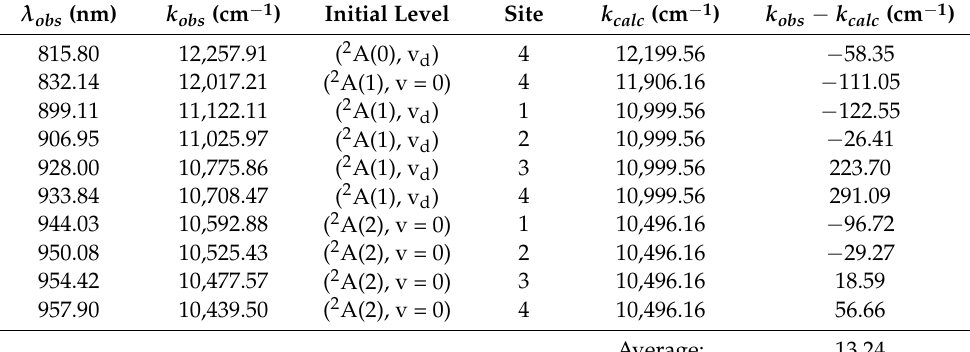
Table 3. Assignments of cooling resonances in Ti:Al 2 O 3 for σ -polarization (mean fluorescence wavelength 763 nm). Wavenumbers for observed and calculated resonances are subtracted for comparison in the last column on the right. The average discrepancy is given in the bottom